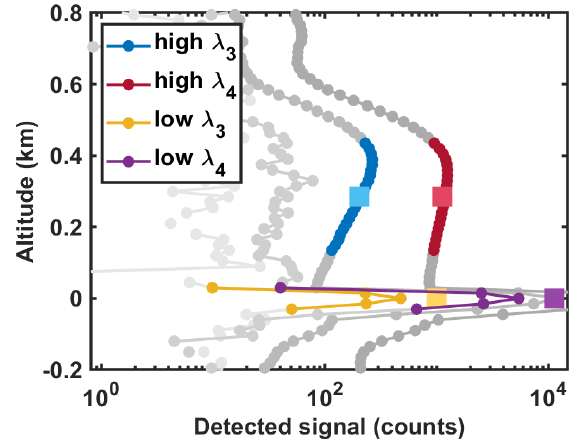
Figure 5. Illustration of surface return DIAL concepts. The legend “high” and “low” refer to high-gain and low-gain channels, plotted at 15m vertical resolution. The high-gain data are temporally aver- aged to 60s, while low gain is a single half second averaged record. The colored circles are averaged (atmospheric) or summed (surface return) to use in the DIAL calculation. These are the P(λ,r) inputs to Eq. (1) and are shown as colored squares on the plot. Grayscale points are not used in the surface return but are still shown here for